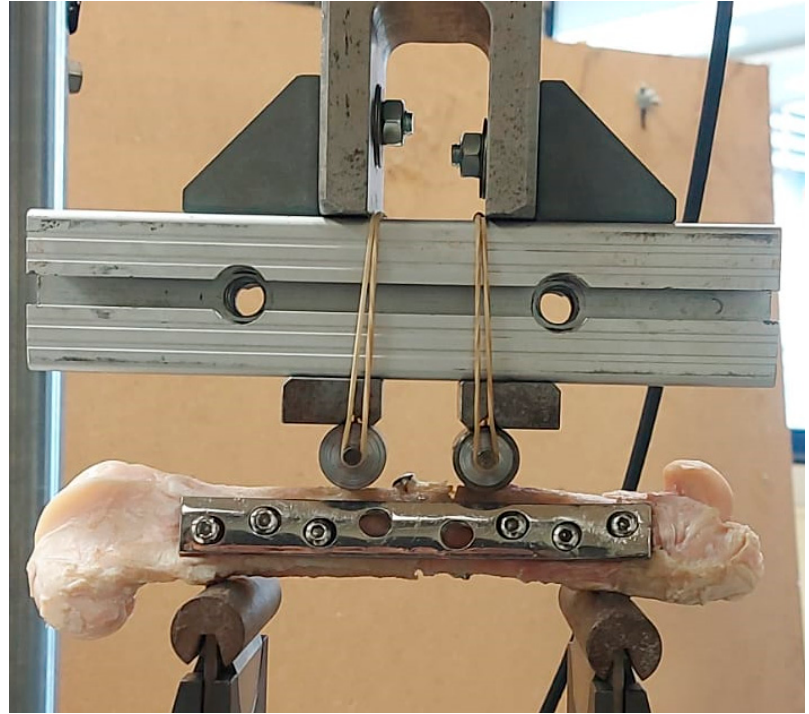
Figure 6. Experimental setup of FPB tests.